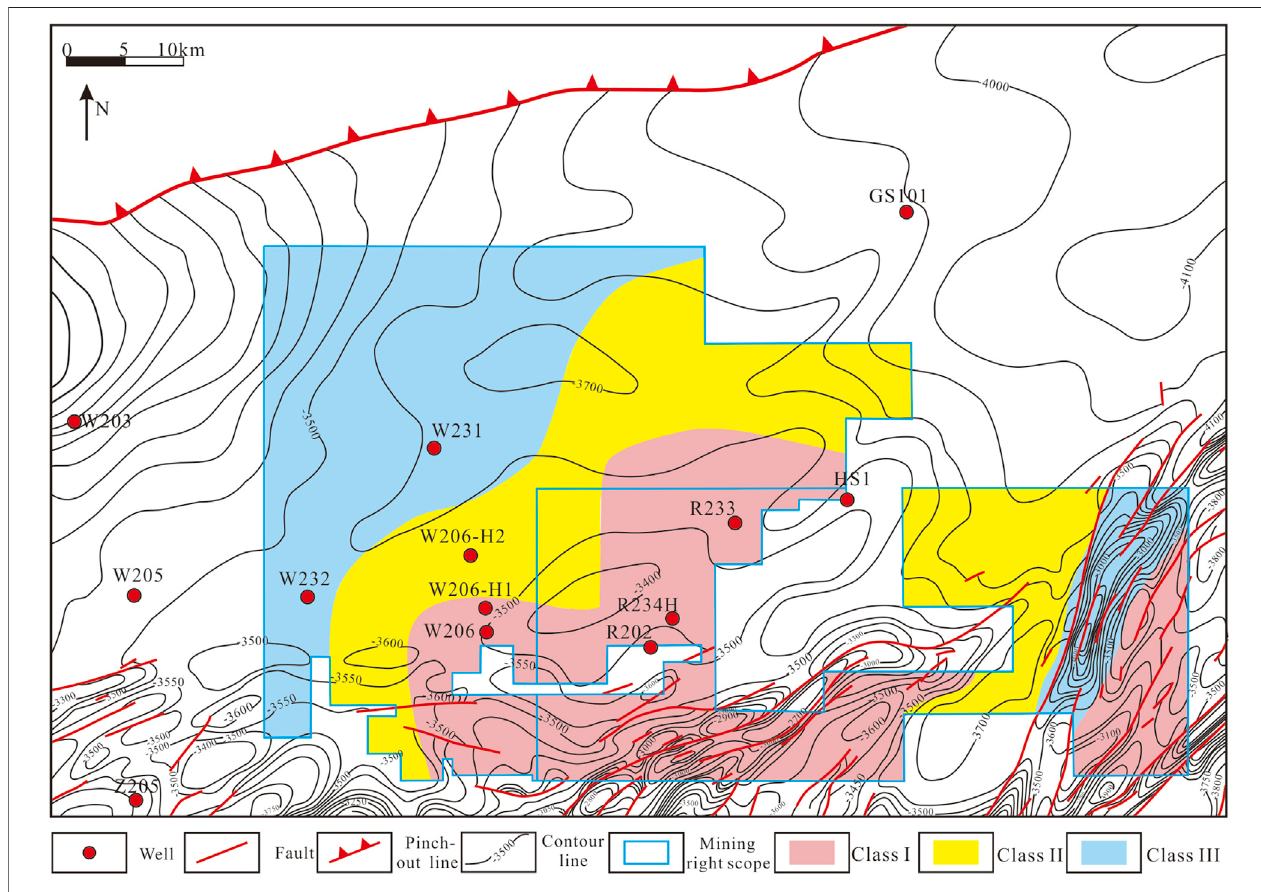
FIGURE 14 | Favorable target areas in the study